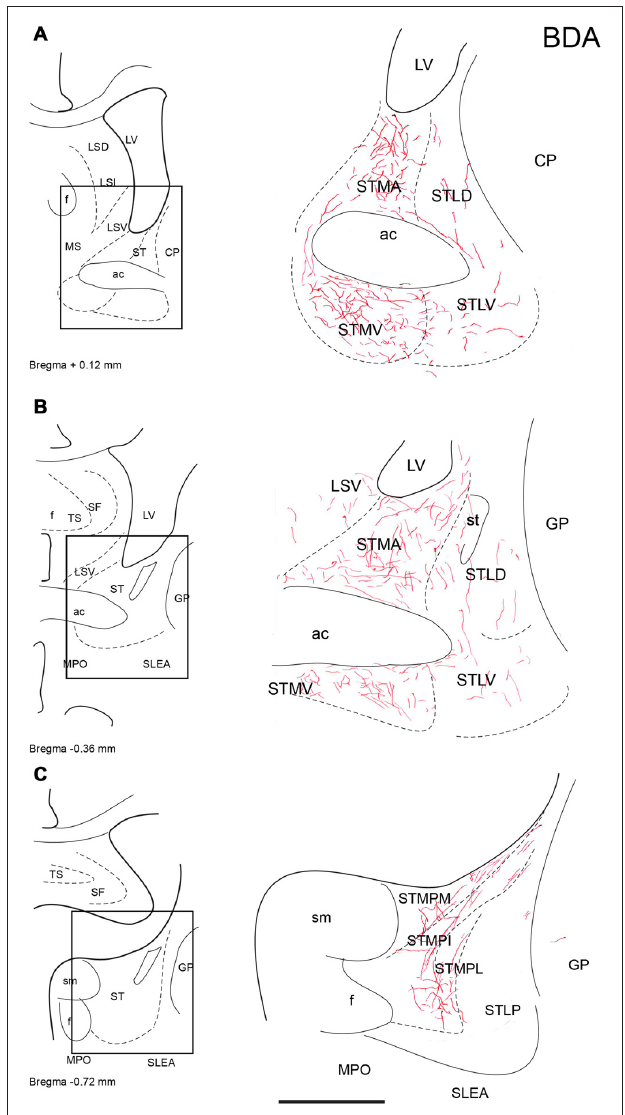
FIGURE 3 | Distribution of anterograde fiber labeling in the bed nuclei of the stria terminalis (ST) after a BDA injection into the NI. Labeled fibers mainly occurred in the medial nuclei. (A–C) Represents the levels that are shown in a camera lucida detail of the corresponding bregma levels. Calibration bar 250 µ